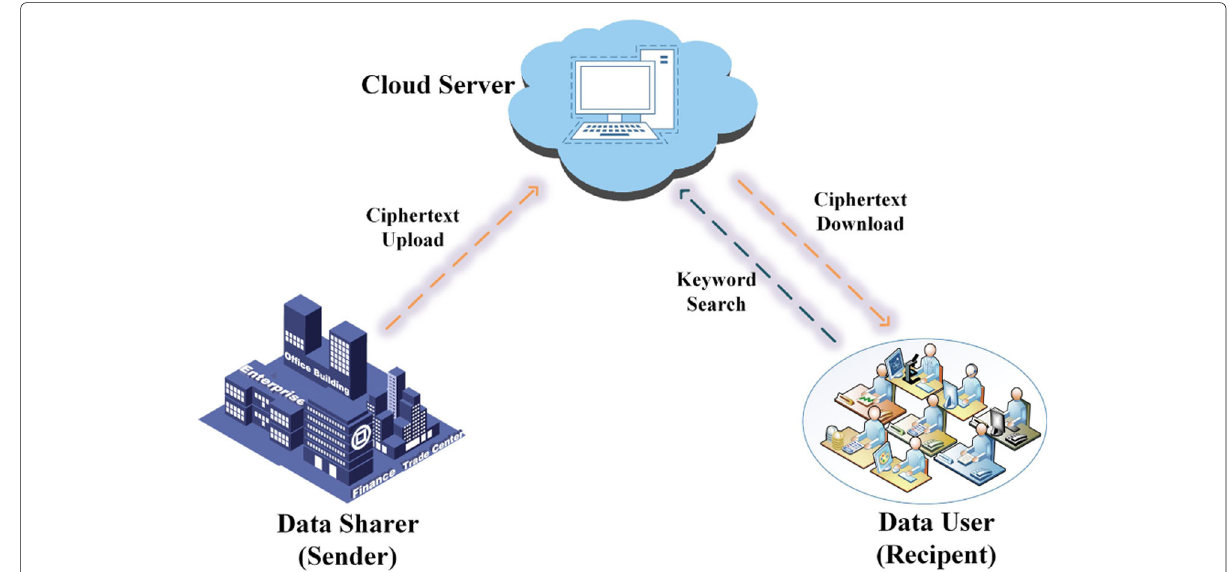
Fig. 1 Model of searchable